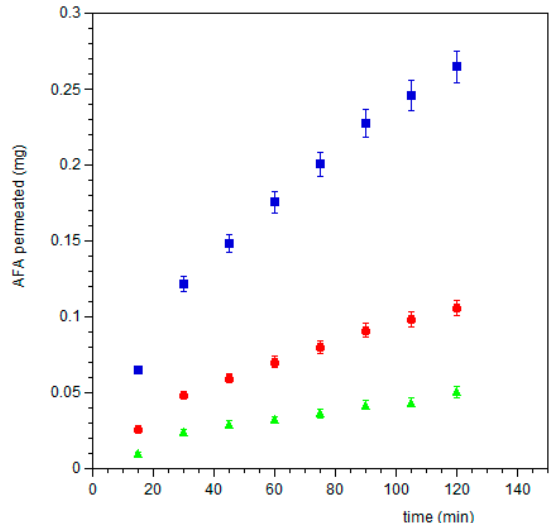
Figure 10. Plot of cumulative amount of AFA permeated across porcine sublingual mucosa vs. time from AFA100 film , AFA300 film, and ▲ solution . Values are presented as means ± SD (n = 12). Extrapolating the fl ux ( J s ) per unit area of AFA through the mucosal membrane at the steady